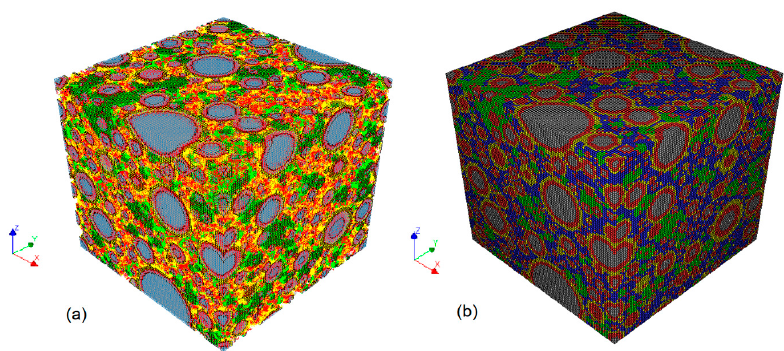
Figure 5. ( a ) Construction of the lattice unit cell based on truncated octahedral; ( b ) positioning of the lattice unit cell on the discretised Representative Elementary Volume (REV) voxels.